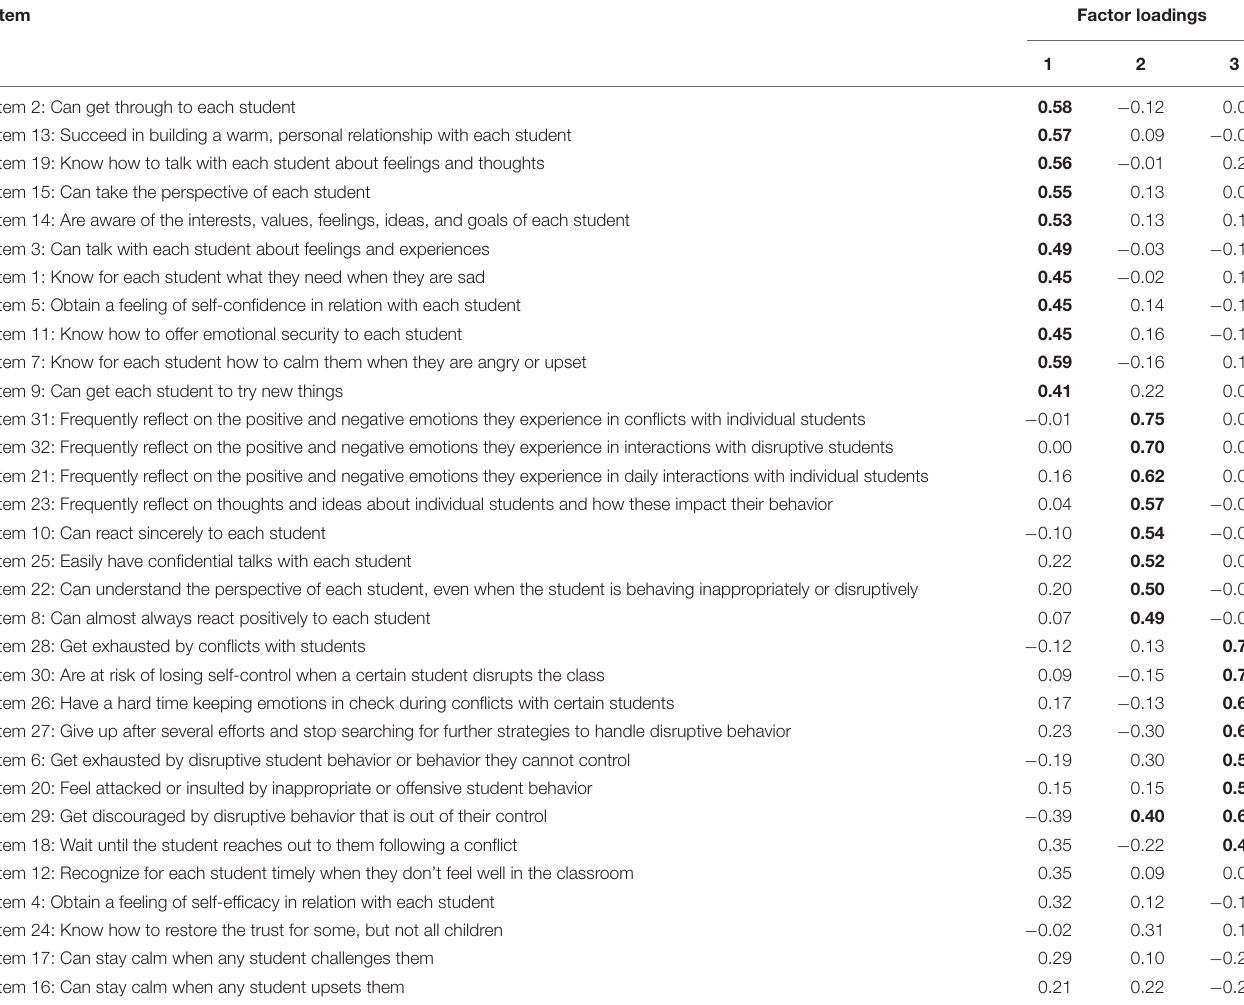
TABLE 4 | Results of exploratory factor analysis for self-efficacy: factor loadings. Item Factor loadings